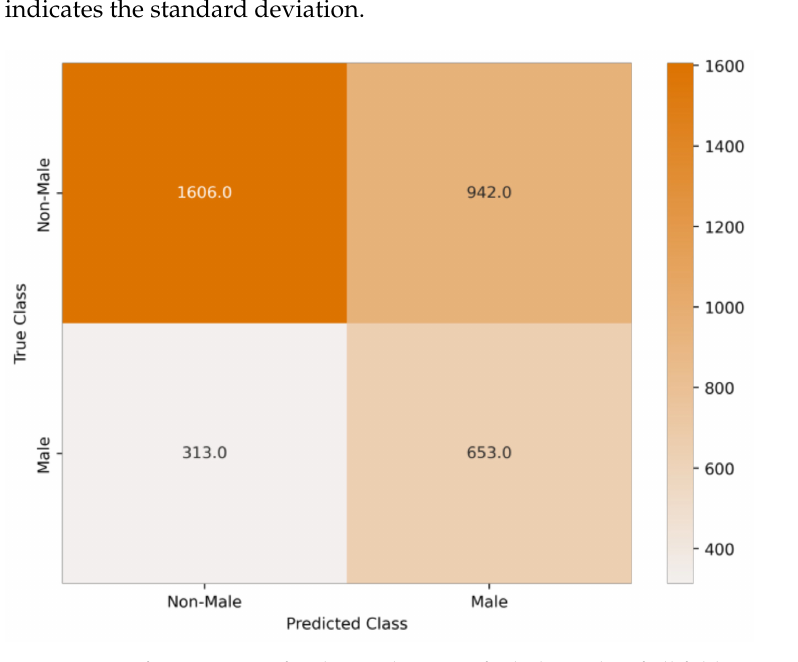
Figure 3. Confusion matrix for the predictions of whole tracks of all